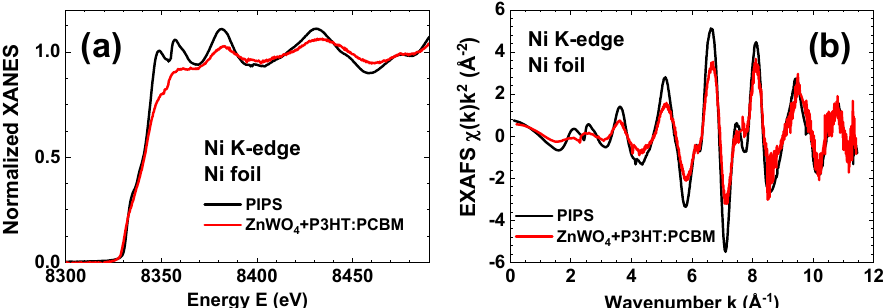
Figure 5. Comparison of the Ni K-edge ( a ) XANES µ ( E ) and ( b ) EXAFS spectra χ ( k ) k 2 of nickel foil measured using novel hybrid and PIPS detectors. k is the wavenumber of the excited